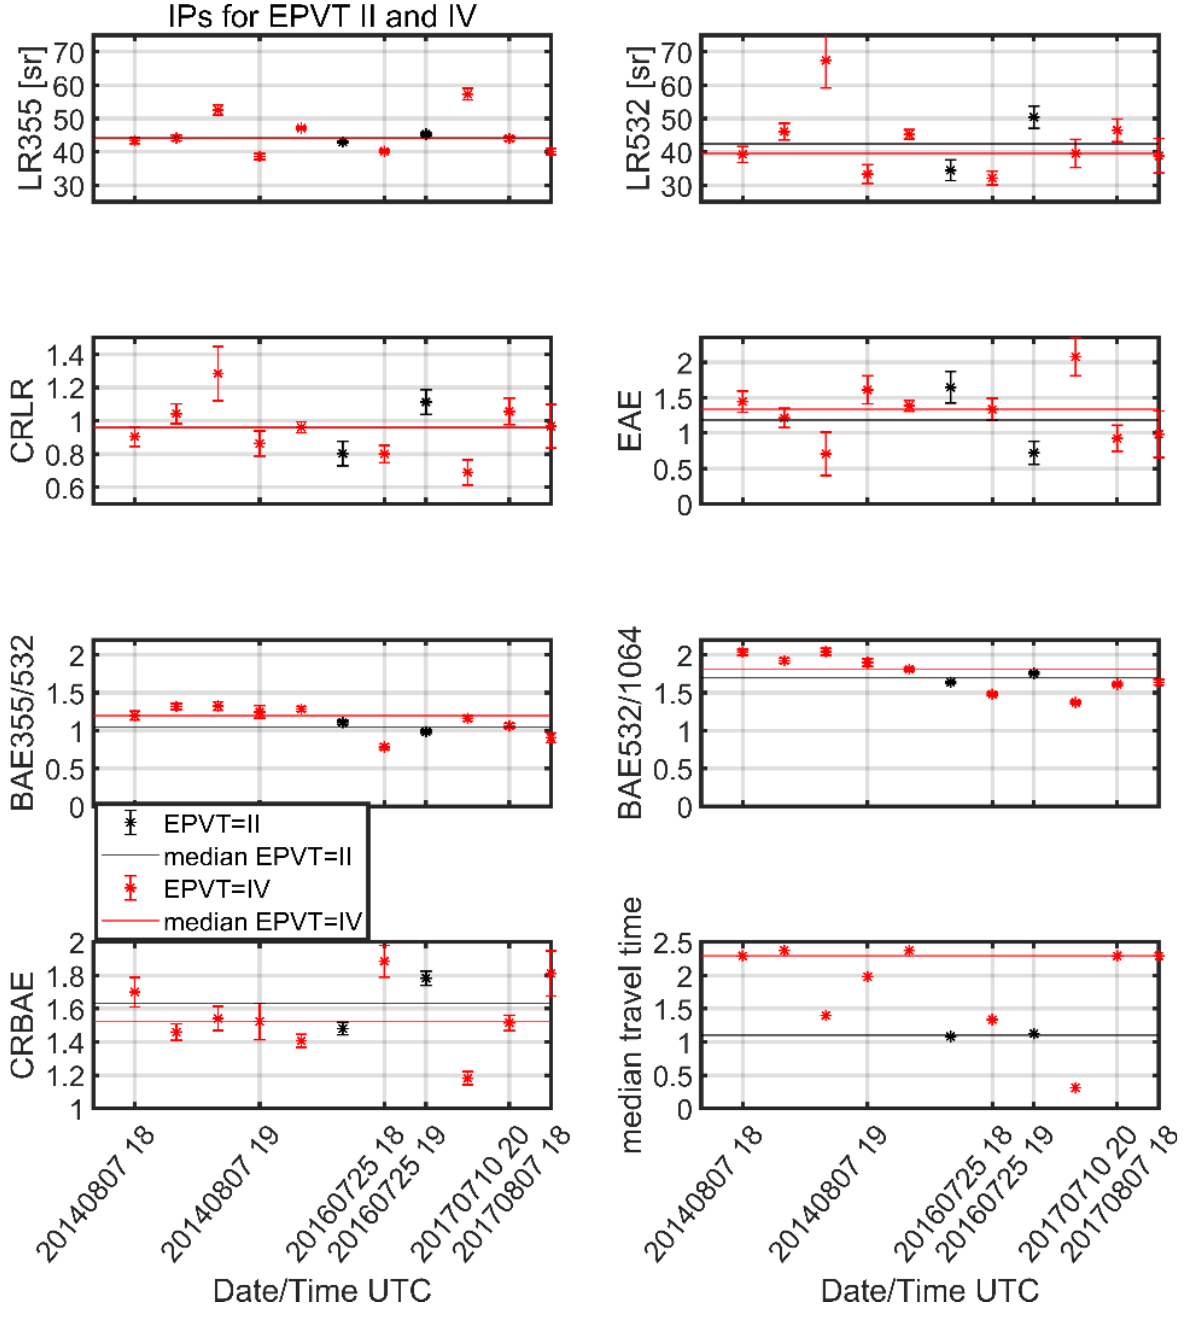
Figure 7. Intensive parameters for EPVT = II and EPVT = IV. Lower right plot shows the travel time for both types.